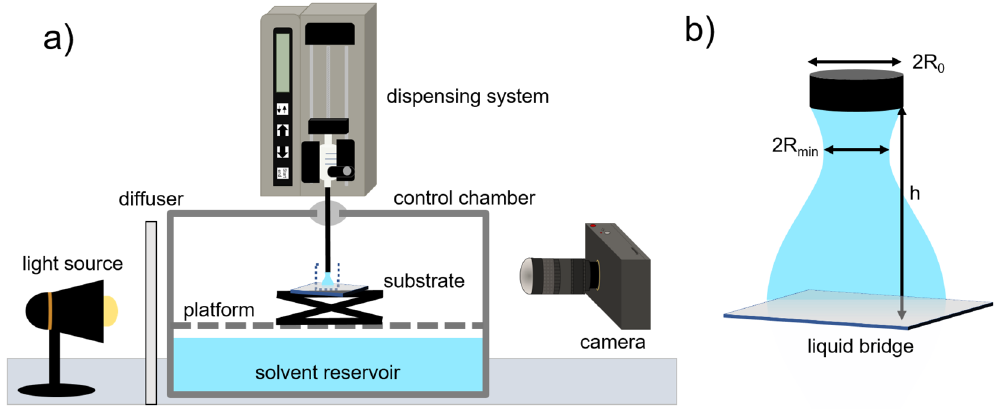
Figure 1. Schematic of the evaporation-controlled DoS instrument with sacrificial solvent reservoir and environmental control chamber, adapted from Lauser et al. 38 (see SI.2); set-up adapted from Dinic and Sharma 23 . To perform DoS measurements, the syringe pump is used to extrude a droplet from a needle with radius R 0 , which then forms a liquid bridge with height h upon contact with the substrate. A high-speed camera captures the evolution of the liquid bridge minimum radius R as the bridge thins in time. The environmental control chamber provides an atmosphere enriched in solvent vapor around the drop to prevent evaporation during this thinning